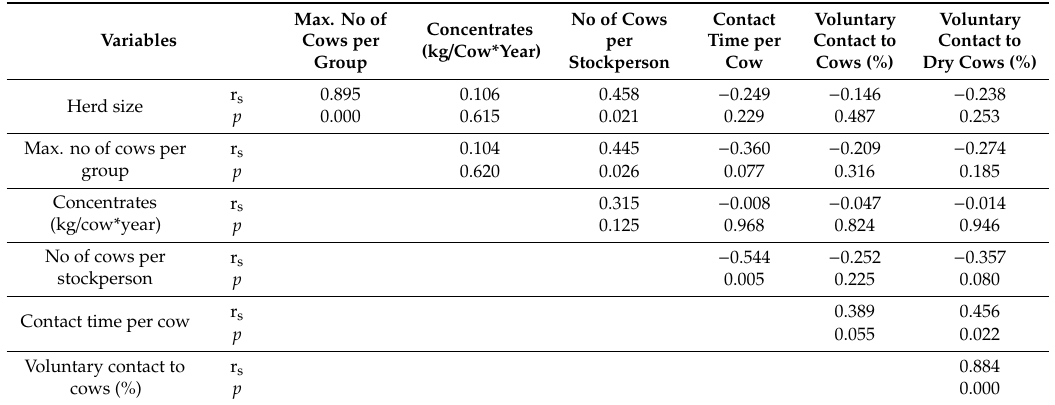
Table A1. Spearman rank correlations (r s ) between metric farm factors considered in multivariable analysis.